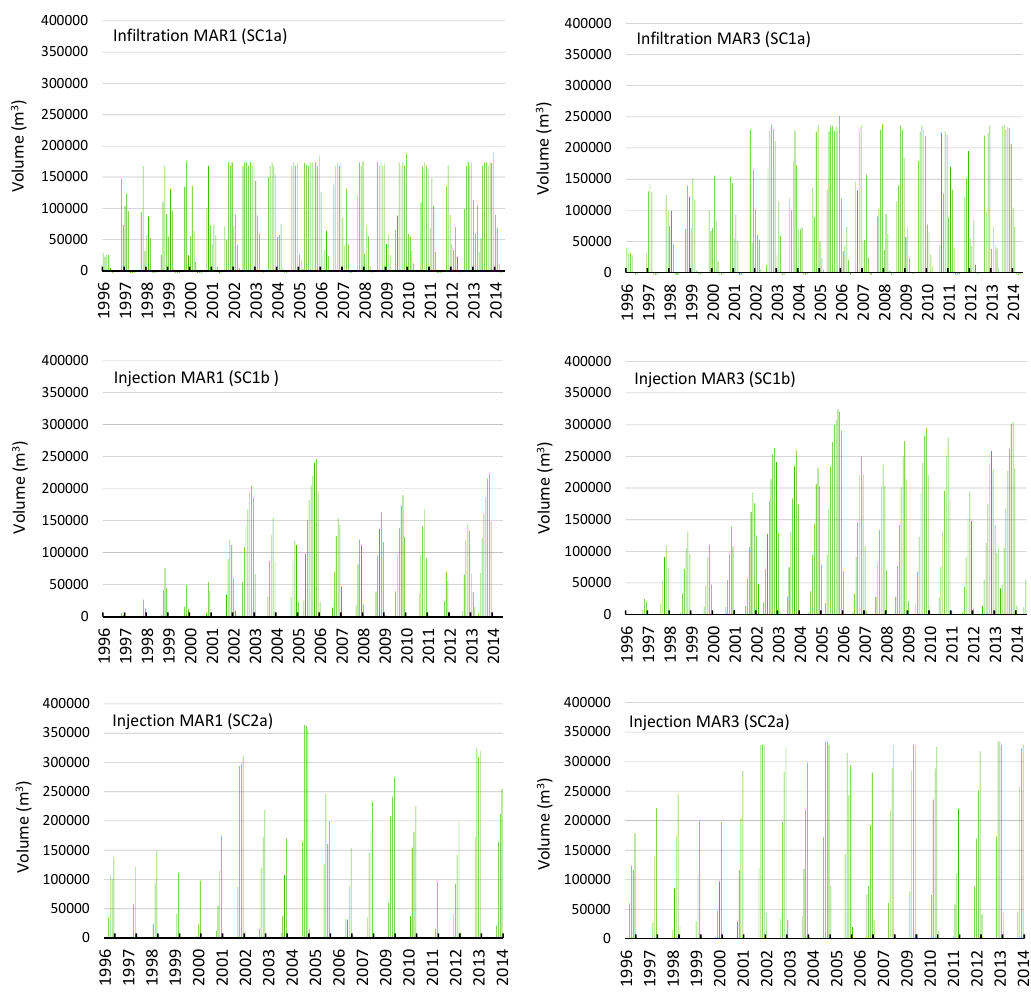
Figure 3. Comparison of monthly modelled recharge volume under infiltration (SC1a) or injection (SC1b, SC2a) type MAR scenarios: SC1a and SC1 b recharge occurs during mid-dry season, recharge triggered by dry season minimum hydraulic head of MAR1~18 mAHD, MAR3~10 mAHD. SC2a recharge occurs early dry season, constant head maintained from 1 April to 1 July, MAR1 constant head of 36 mAHD, MAR3 constant head of 20 m AHD.